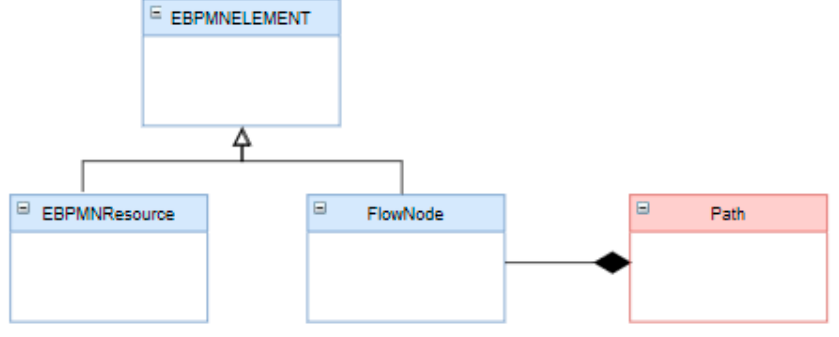
Figure 10. eBPMN extension with PATH class.